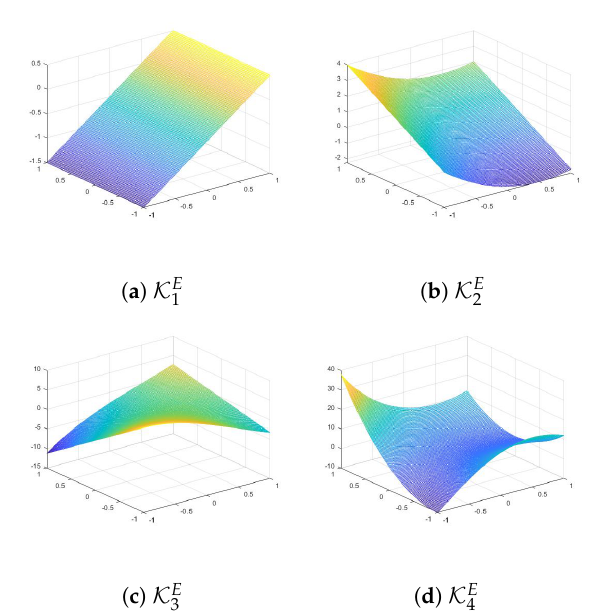
Figure 6. Plot of K E